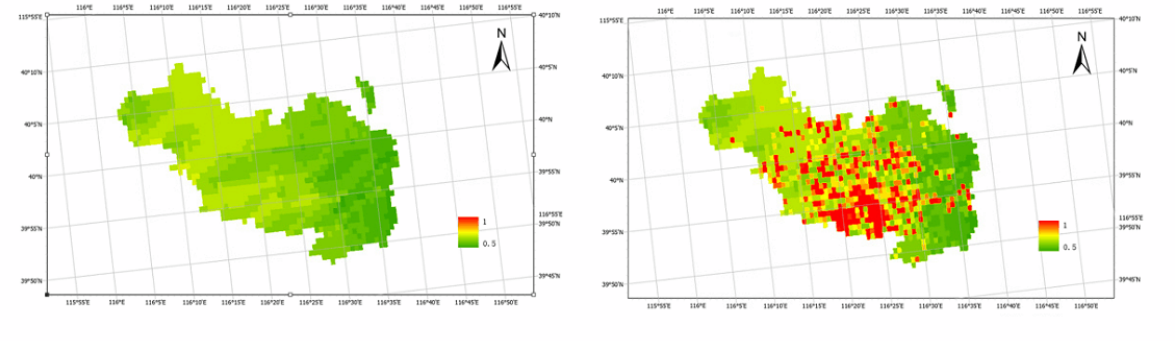
Figure 11. Locations of smartphone photographs in Beijing obtained from social media in November 2021, with corresponding PM 2.5 concentrations estimated by the MIFNN model.